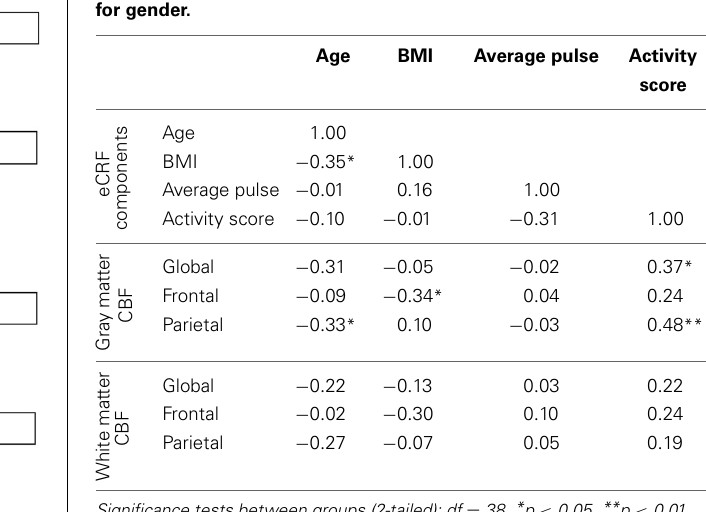
Table 4 | Partial correlations between the individual components used to derive eCRF and measures of blood flow, while controlling for